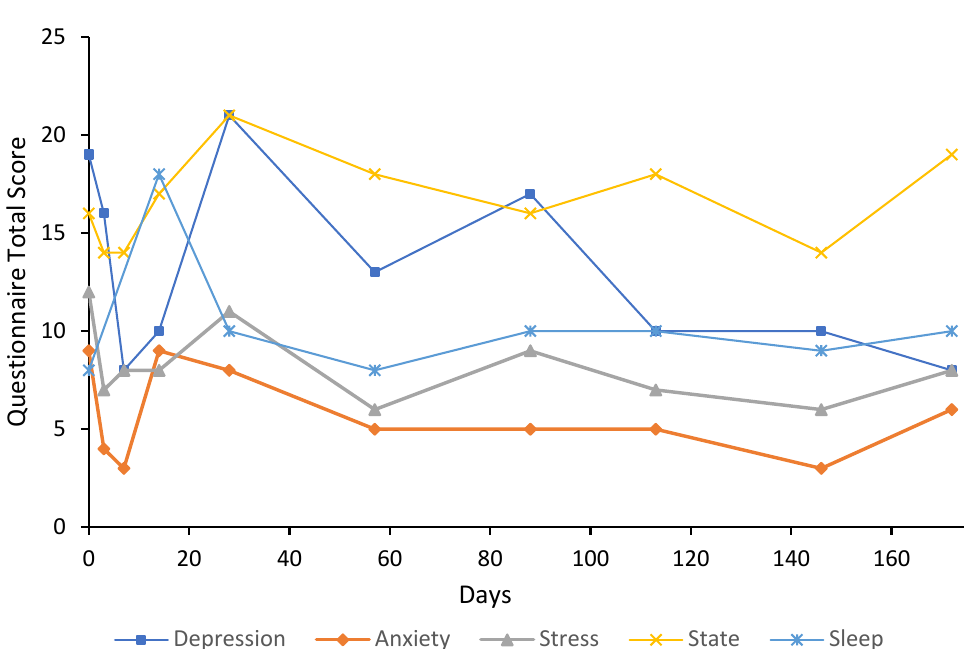
Figure 7. Line graph showing Case 7 results from the DASS-21 (depression, anxiety, and stress subscales), SSAI-6, and JSS at each follow-up. The participant was treated with an eight-day flumazenil infusion without re-treatment during the follow-up period.